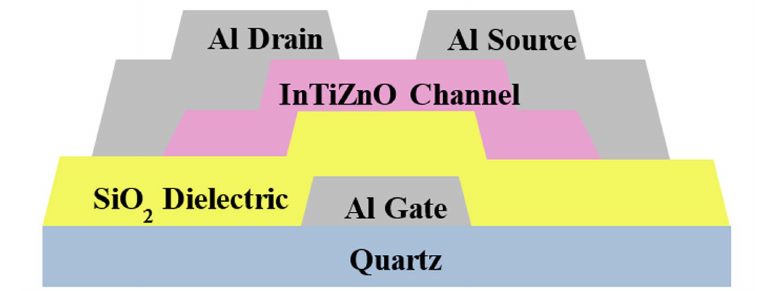
Figure 1. Schematic diagram of the sputtered InTiZnO thin film